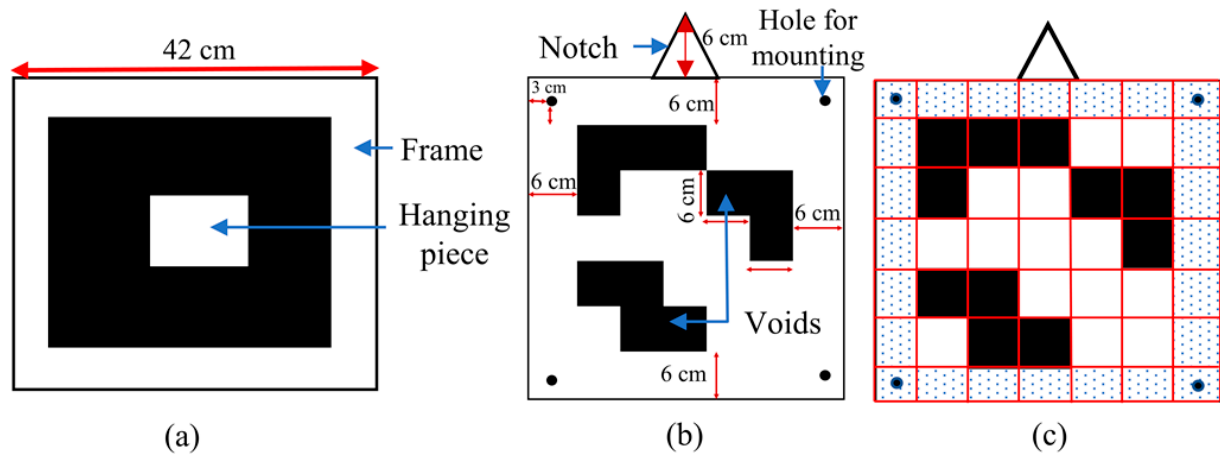
Figure 2. ( a ) Boundary frame of the 3DUID and the hanging piece, which is to be avoided during construction, and ( b ) a conceptual 3DUID prototype with red lines indicating the dimension obtained using a minimum mappable unit, and a triangular notch on the top for automated georeferencing and coregistration. The black blocks represent voids where the material has been removed. ( c ) Gridding approach for coding and decoding 3DUID.